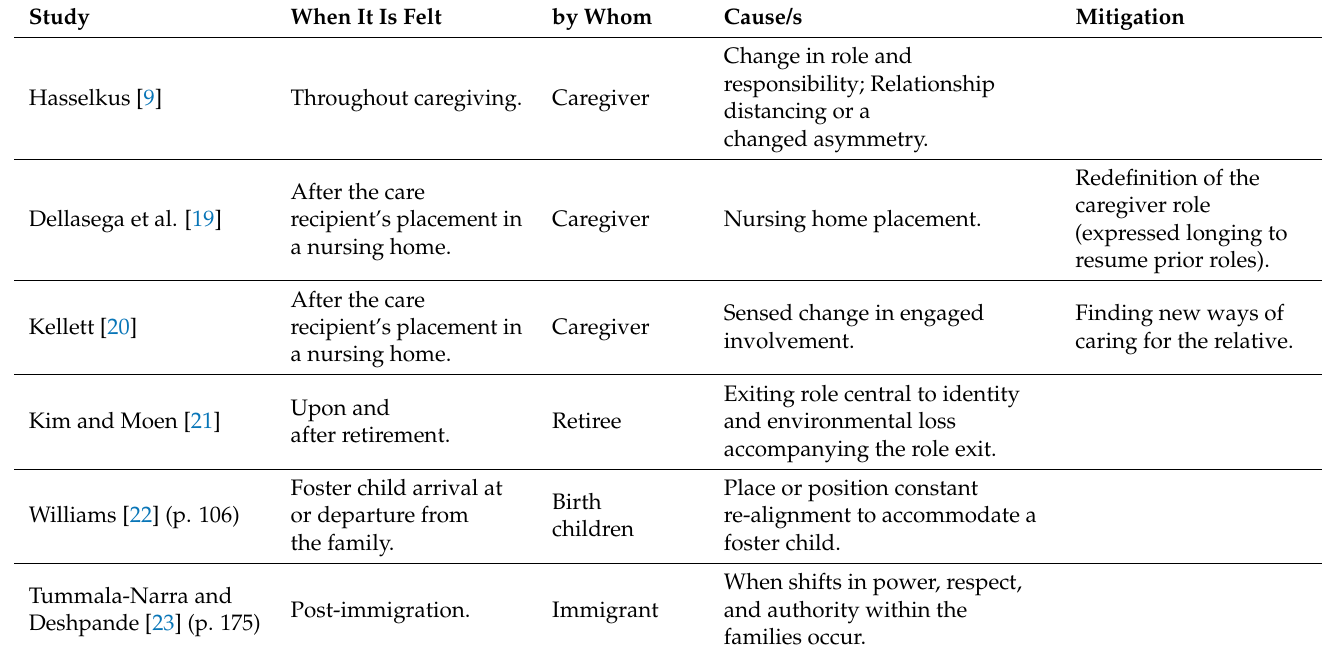
Table 1. Studies on the sense of role